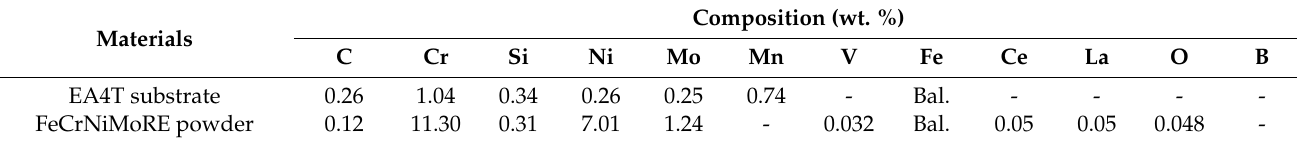
Table 1. Chemical composition of materials.